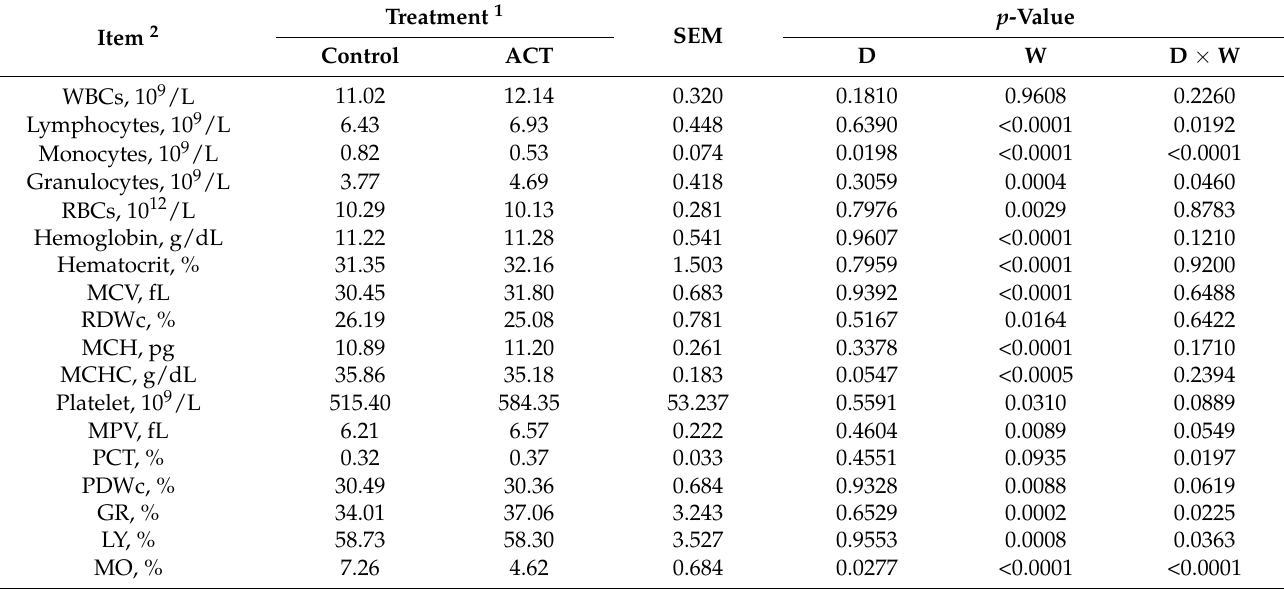
Table 10. Complete blood count analysis in